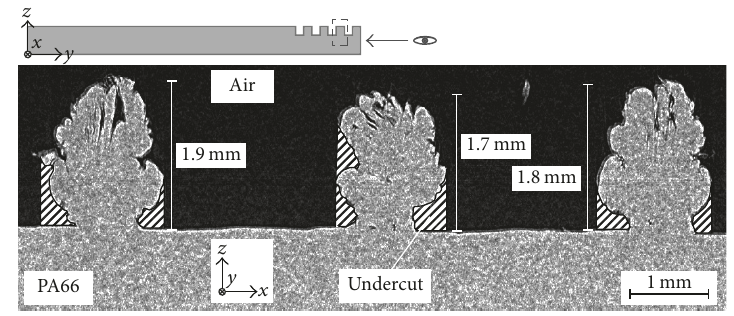
Figure 8: CT image of prestructured joining partner A (PA66) with generated undercuts.